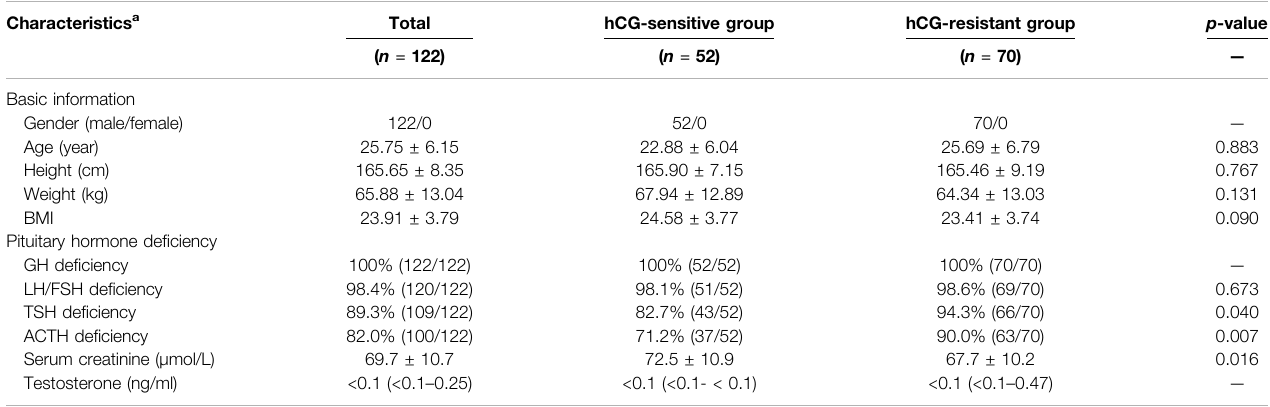
TABLE 2 | Clinical characteristics of the participants in validation cohort. Characteristics